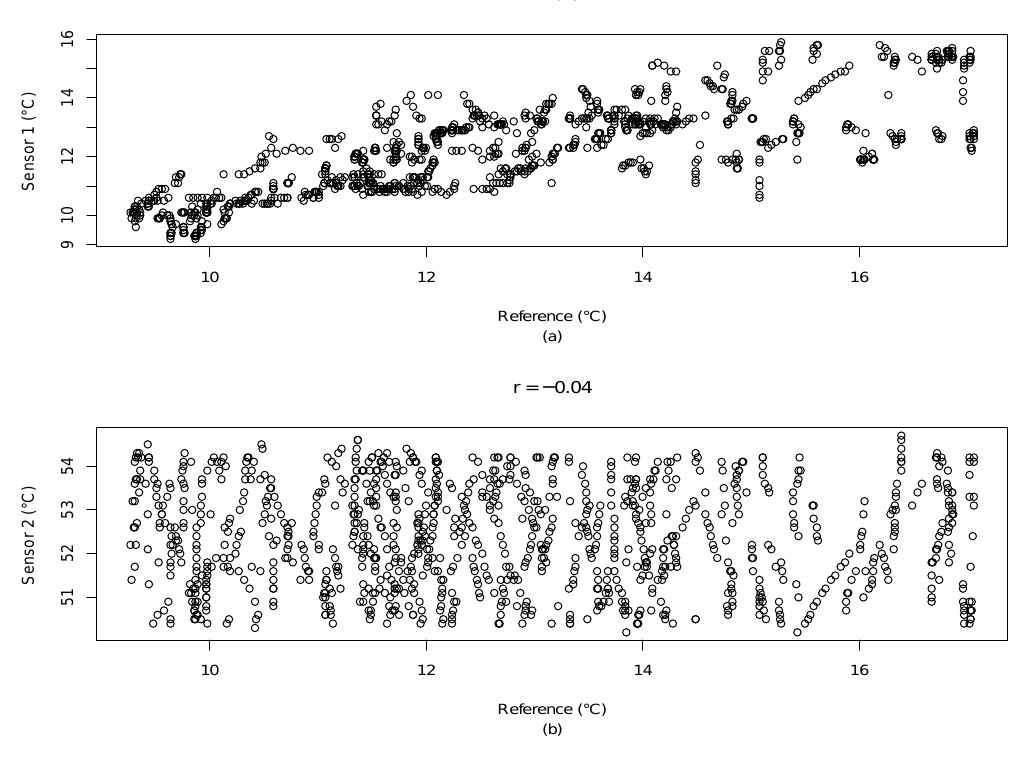
Figure 4. Scatter plot between the reference data ( x -axis) and ( a ) the correlated Sensor 1; and ( b ) the uncorrelated Sensor 2 (Dataset